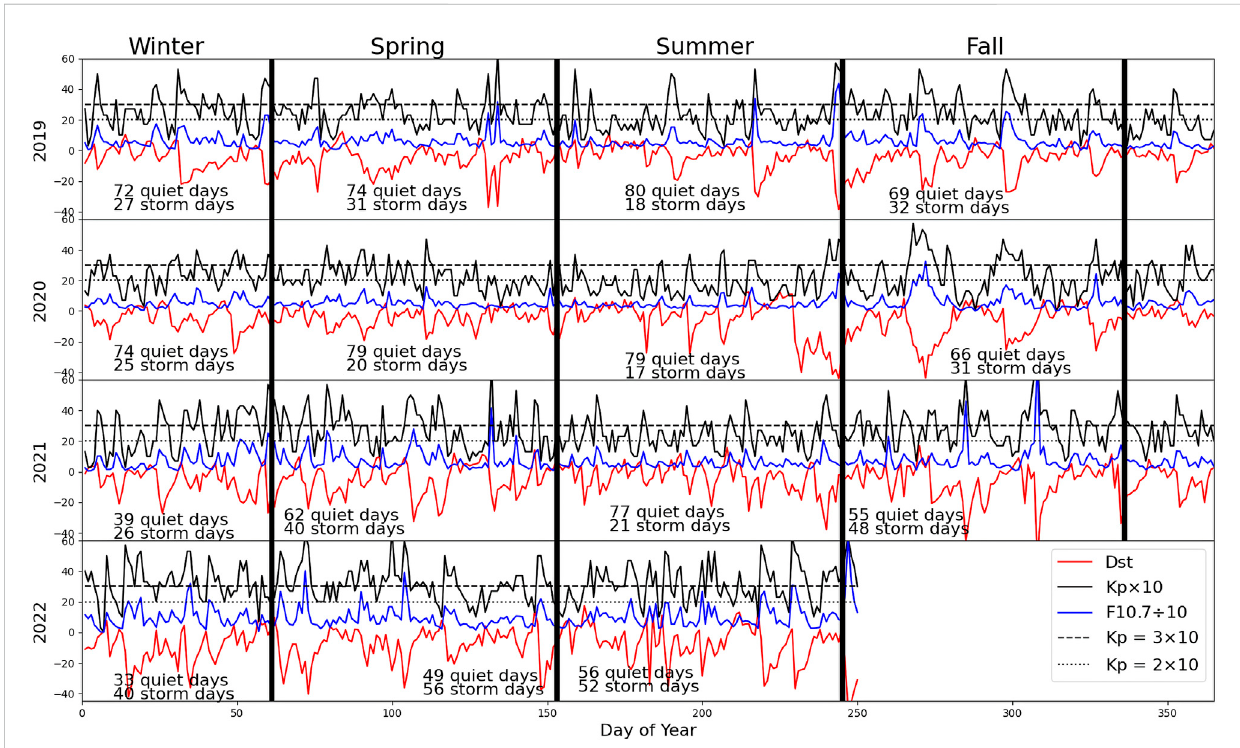
FIGURE 1 SolarandgeomagneticconditionsforJanuary2019 – August2022.Thesolidblackverticallinesdividetheyearintofourseasons.Black,red,andblue lines show thedaily maximum Kp, daily mean Dst (nT)and daily mean radio F10.7 (solar fl ux units). Dashed and dotted black lines show Kp = 3 and Kp= 2, respectively.ThenumbersineachboxshowthenumberofdayswithKp ≥ 3.0(stormdays)andwithKp < 3.0(quietdays).Forviewingpurposes,Kpindexis multiplied by 10 and F10.7 is divided by